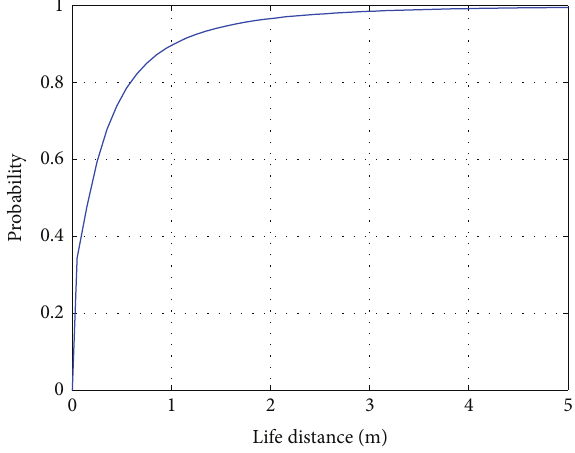
Figure 17: Discrete cumulative probability density function of the echoes life distance in the urban city center environment.